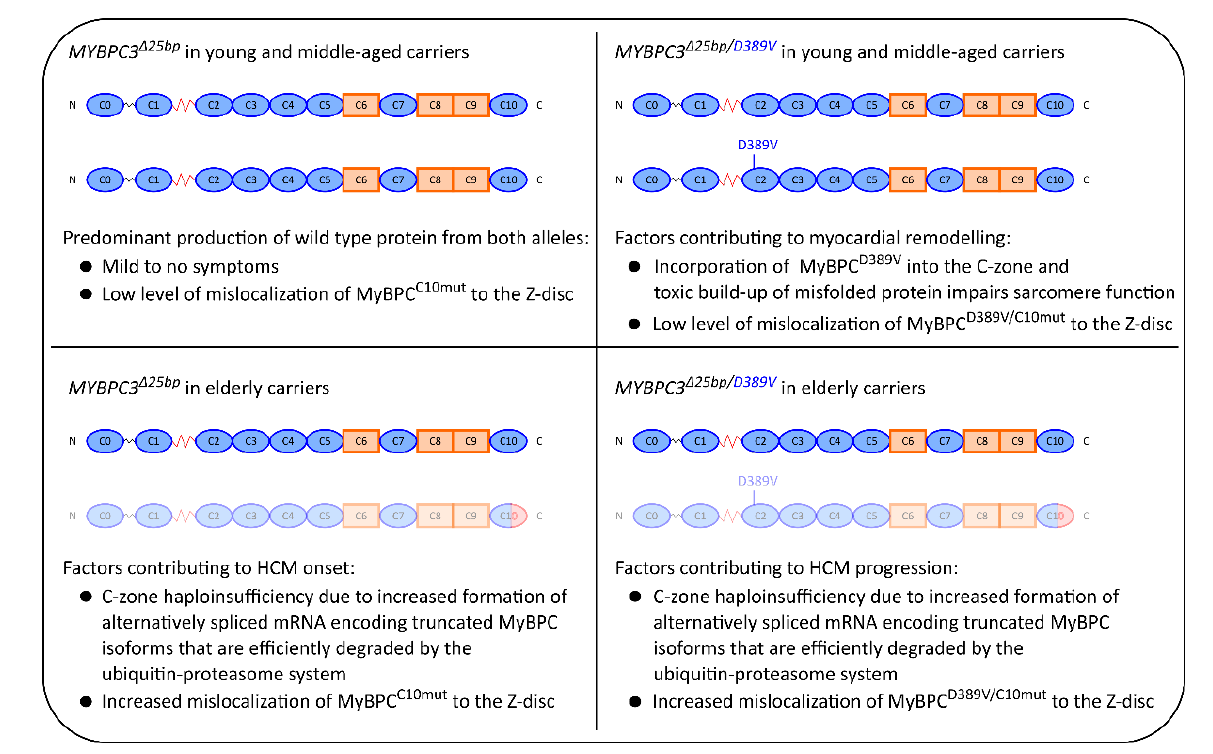
Figure 7. Proposed disease mechanisms as a result of age-related alternative splicing. All carriers in this model are heterozygous for one of the variants and produce wt protein from at least one allele at all times. Young and middle-aged MYBPC3 Δ25bp carriers predominantly produce wt mRNA from both alleles, resulting in mild or absent symptoms. Incorporation of MyBPC D389V into the contractile zone of sarcomeres in young and middle-aged MYBPC3 Δ25bp/D389V carriers leads to myocardial remodeling mediated by a poison polypeptide mechanism. As patients age, the alternatively spliced transcript on the allele carrying the intron deletion predominates in both MYBPC3 Δ25bp and MYBPC3 Δ25bp/D389V carriers. We assume that the truncated forms of the protein are efficiently eliminated by the ubiquitin–proteasome system in cardiomyocytes with smaller fractions of MyBPC C10mut and MyBPC D389V/C10mut mislocalizing to the Z-disc. As a result, C-zone haploinsufficiency is predicted to become the dominant disease mechanism in elderly MYBPC3 Δ25bp and MYBPC3 Δ25bp/D389V carriers.